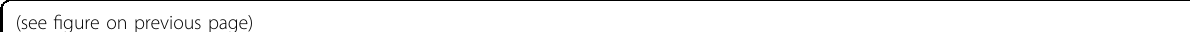
Fig. 5 The heterogeneity of macrophages during the development of TAAD. a Heatmap showing distinct expression pro fi les of the three macrophage subpopulations. b The expression of markers for pro-in fl ammatory chemokines, M1-polarized, M2-polarized, and tissue-resident macrophages in the three subpopulations. c GO terms enriched in the molecular signatures of each subpopulation. Adjusted P value of hypergeometric test <0.05. d Subpopulation-speci fi c regulons of each subpopulation revealed by SCENIC analysis. e smFISH results showing the spatial distribution of the three macrophage subpopulations in mouse aorta. Scale bars, 50 μ m. TA, tunica adventitia; TM, tunica